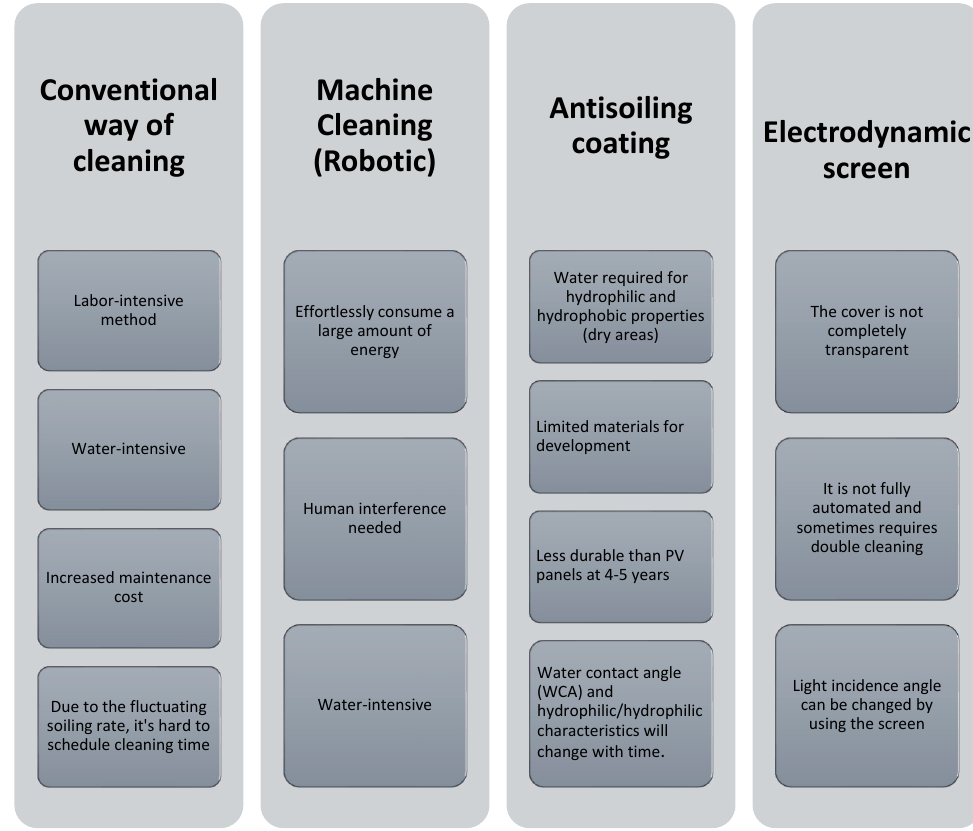
Figure 8. Summary of key challenges of PV anti ‐ soiling methods.